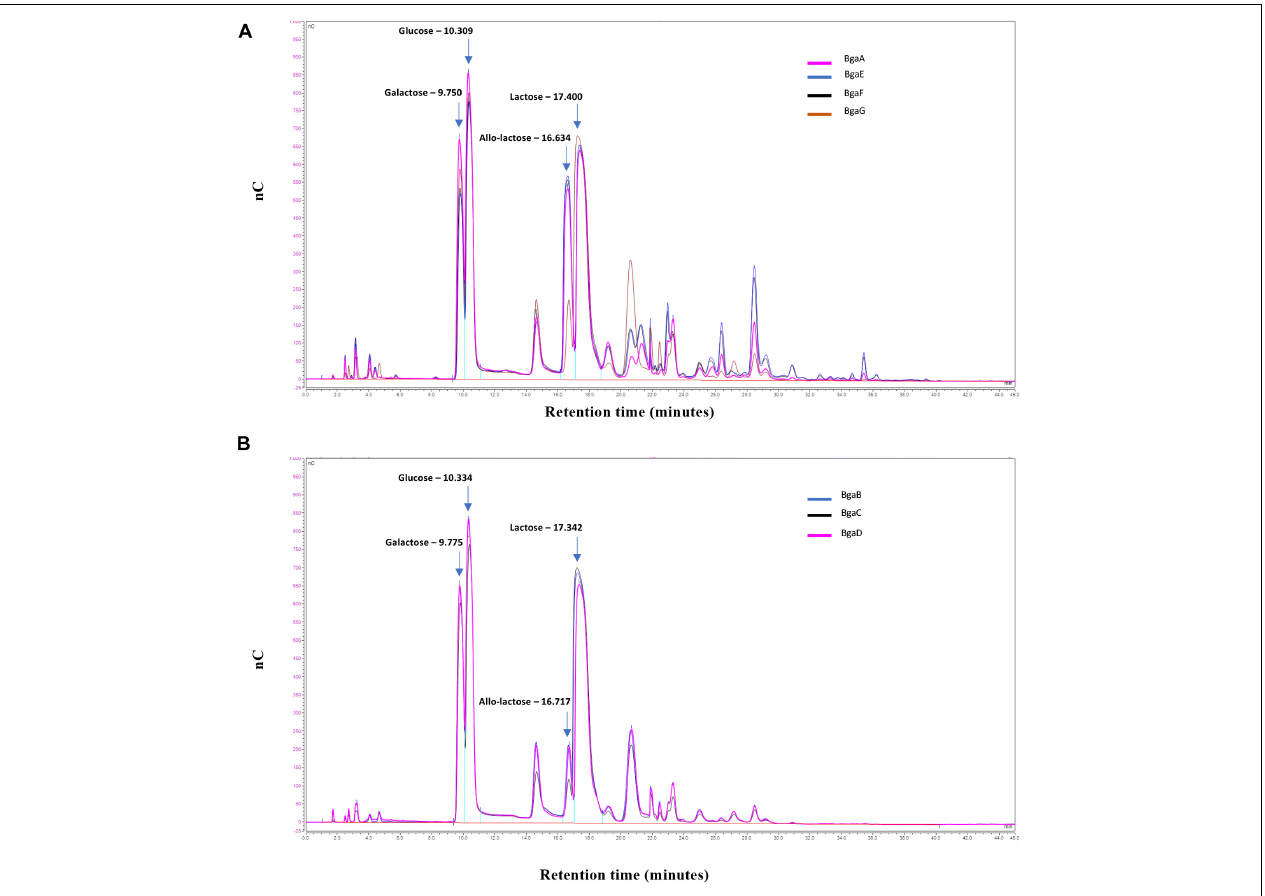
FIGURE 3 | GOS synthesis. HPAEC/PAD elution patterns of the oligosaccharides obtained by transgalactosylation activity of BgaE, BgaE, BgaF or BgaG (A) and BgaB, BgaC or BgaD (B) nC: nanoCoulomb (Quantitative currency measure proportional to the carbohydrate